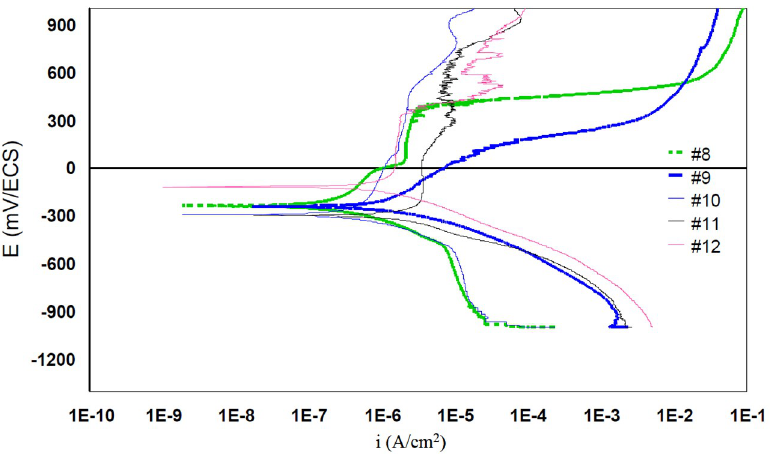
Figure 6. Semi-logarithmic potentiodynamic curves for the 316L (#8 and #9) grades and 904L (#10, #11, and #12) grades, which are currently used for items in contact with the skin.